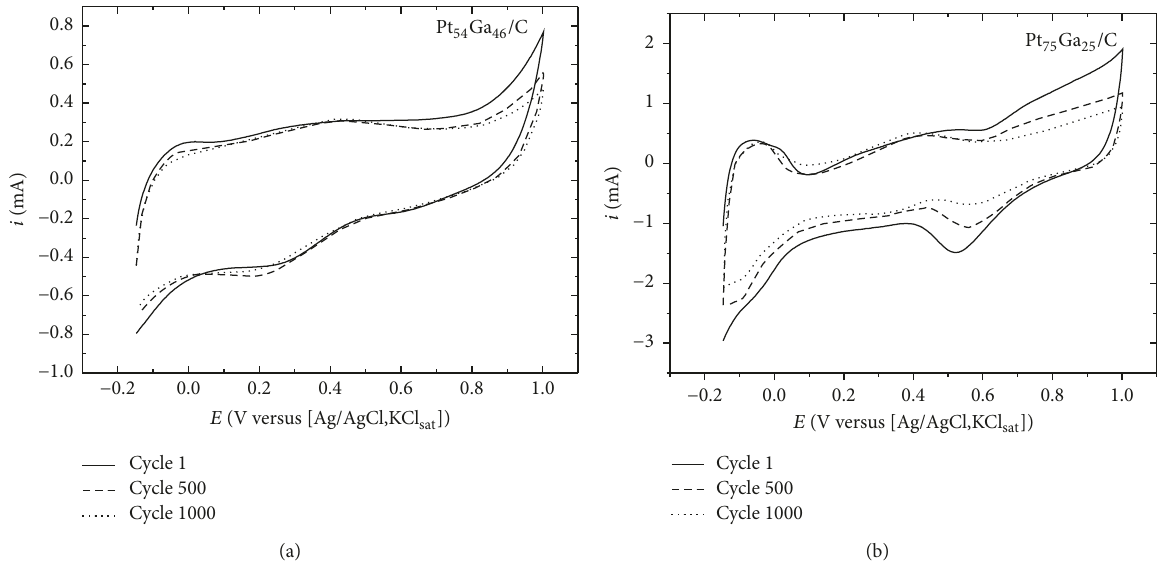
Figure 6: Representative CV of the PtGa/C electrocatalyst in H 2 SO 4 0.5 mol L −1 supporting electrolyte, from − 0.15 to 1.0V versus Ag/AgCl, KClsat, and scan rate of 20 mVs −1 . (a) Pt 54 Ga 46 /C; (b) Pt 75 Ga 25 /C.